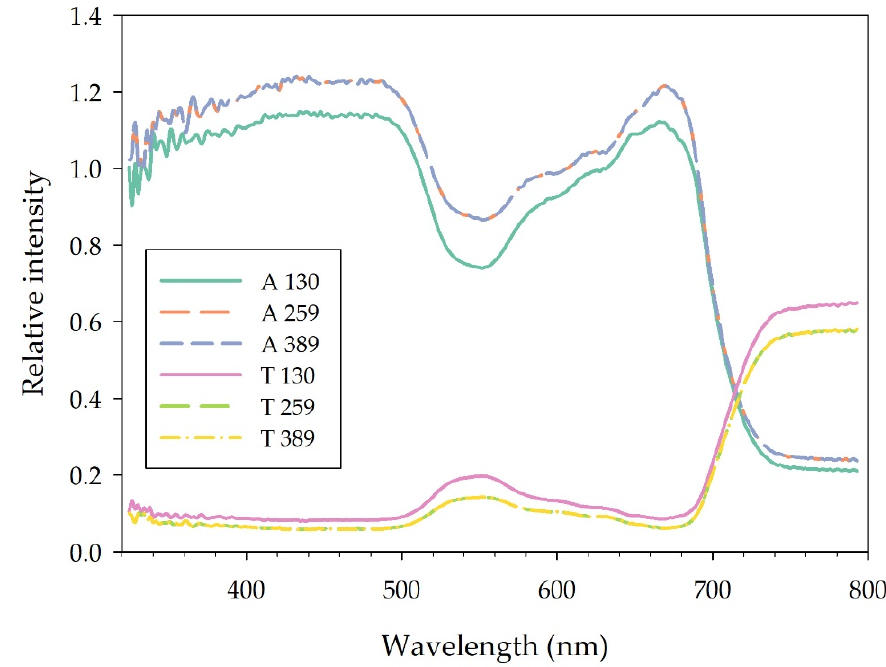
Figure 4. Adaxial leaf spectral (380–790 nm) absorbance (A) and transmittance (T) of lettuce type Batavia cv ‘Blackhawk’ grown under three different light intensities (130, 259, 389 µ mol m − 2 s − 1 ). Mean values ( n = 5, 30 DAT).